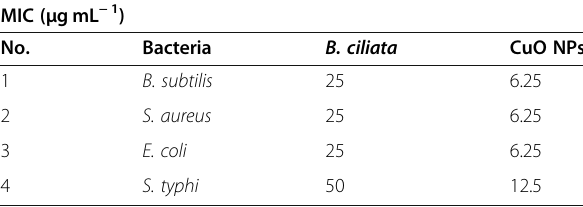
Table 3 Minimum inhibitory concentration (MIC) of B. ciliata, CuO NPs and various pathogenic bacterial strain MIC ( μ g mL − 1 )